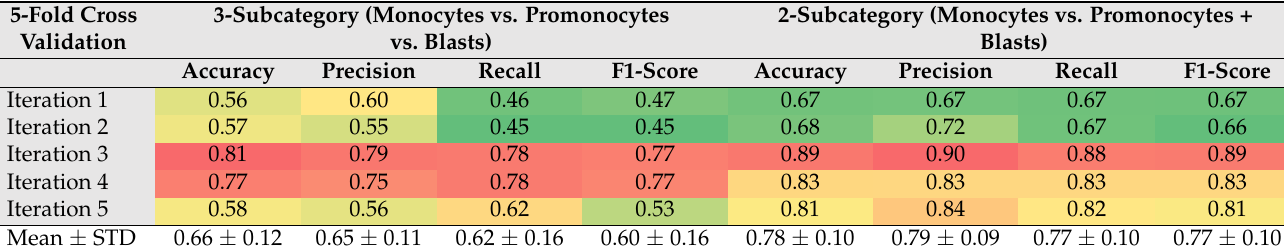
Table 3. Overall performance of fivefold cross validation using the Inception_resnet CNN model. 5-Fold Cross